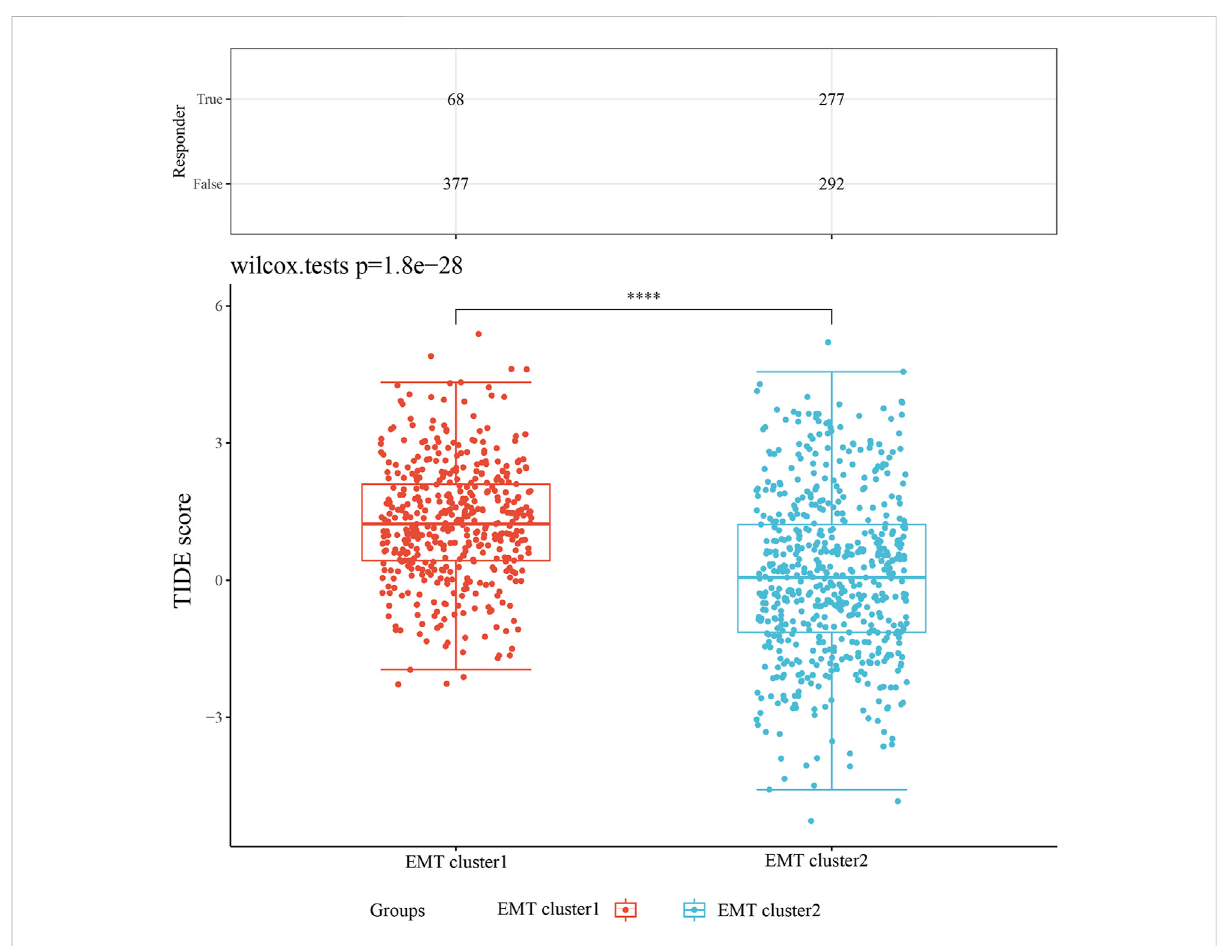
FIGURE 3 Intratumoral heterogeneity of NSCLC. The TIDE test was used to predict response to immune checkpoint inhibition therapy.